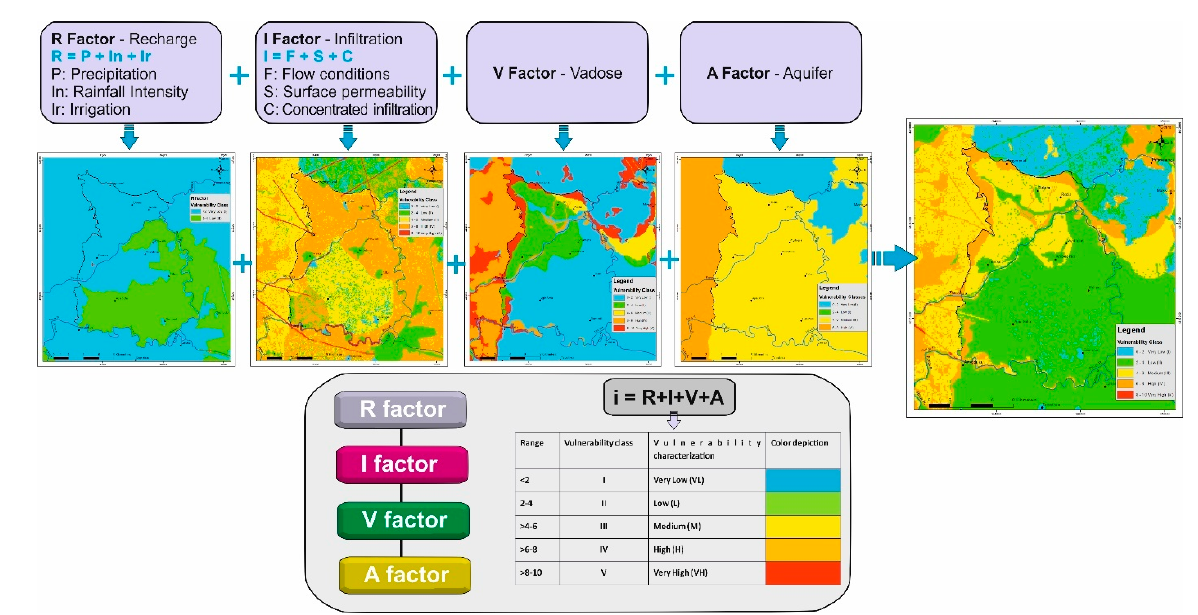
Figure 4. Schematic presentation of RIVA method (according to [26]).